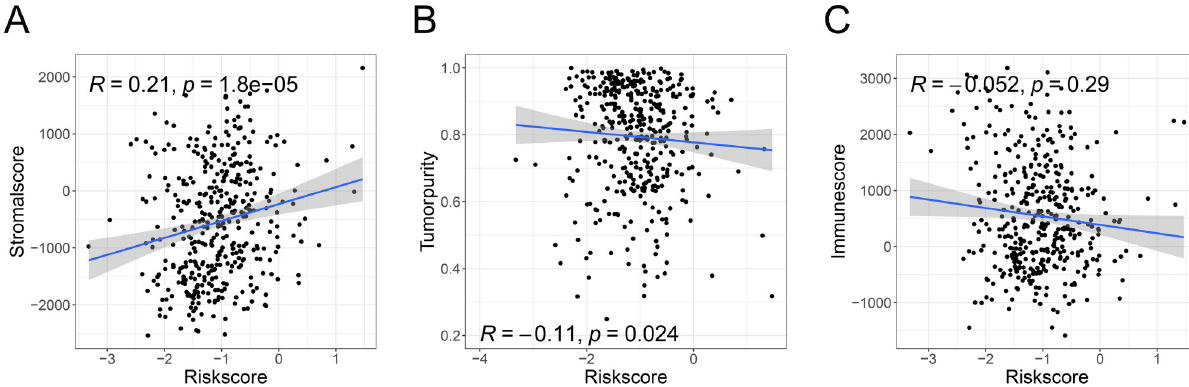
Fig 8. The risk score was significantly related to the TME based on the ESTIMATE algorithm. The stromal score was positively correlated with the risk score (A), and tumor purity was negatively correlated with the risk score (B). There was no significant difference between the risk score and immune score (C). TME, tumor microenvironment.